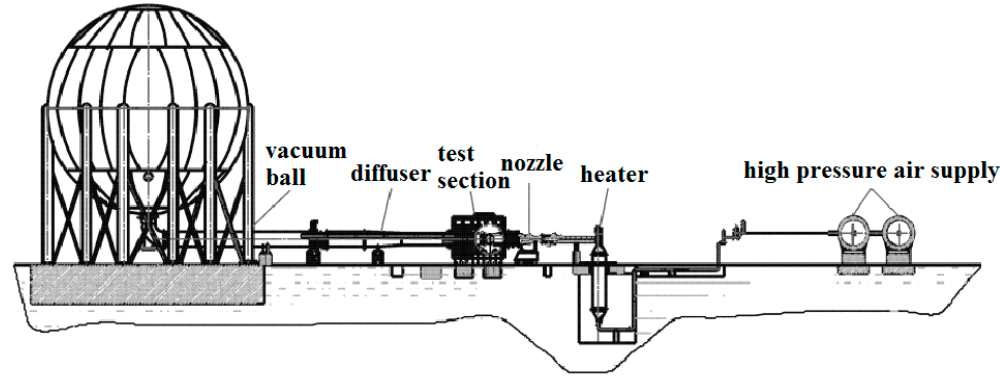
Figure 4. Hypersonic wind tunnel of Nanjing University of Aeronautics and Astronautics (NHW).